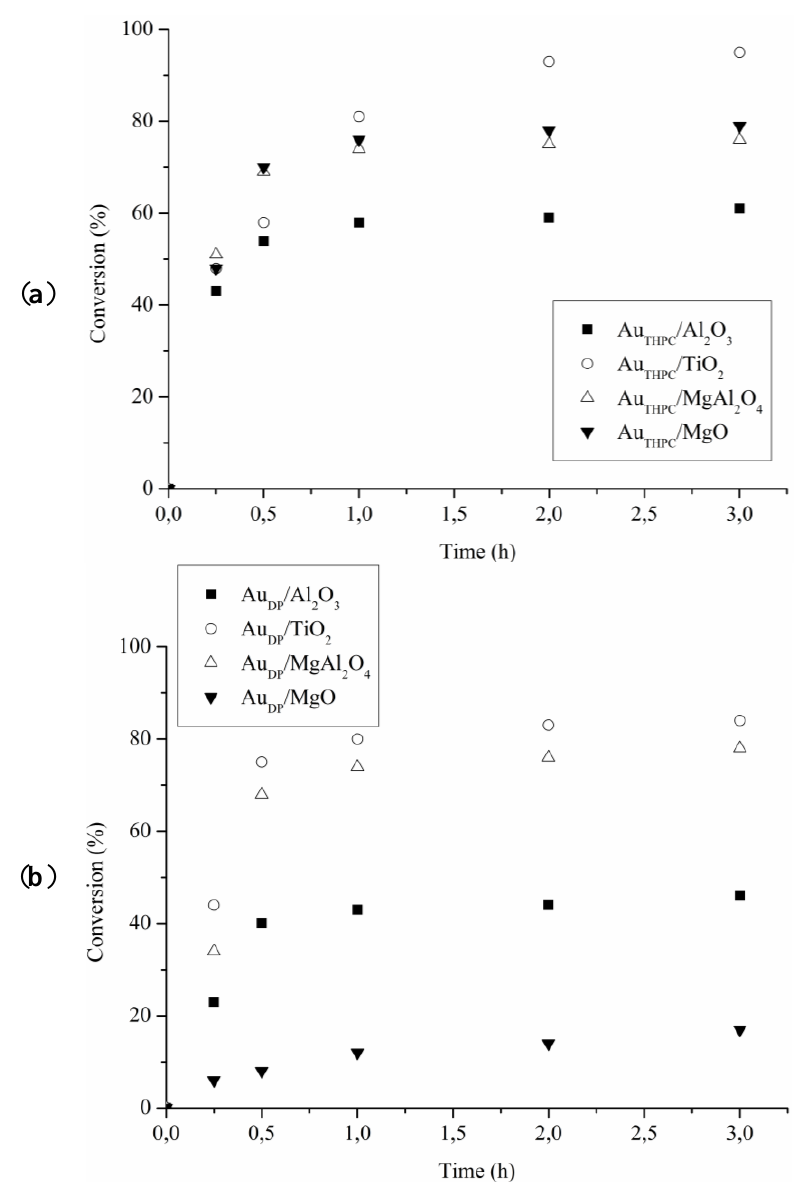
Figure 5. Reaction profiles for ethanolamine oxidation using ( a ) Au ( b ) Au DP